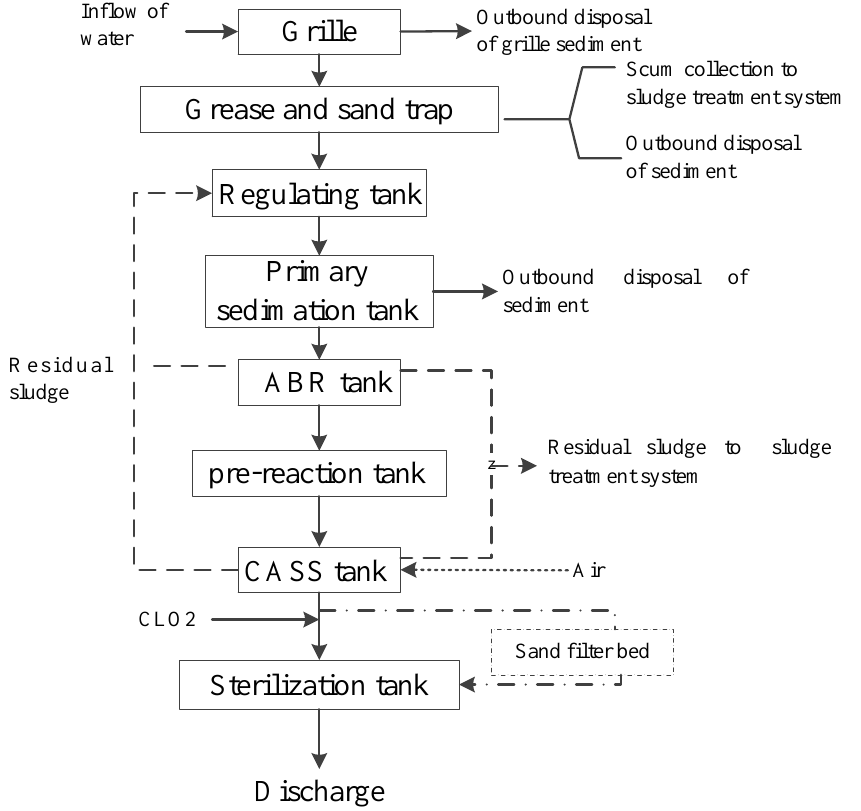
Figure 3. ABR + CASS process flow diagram.